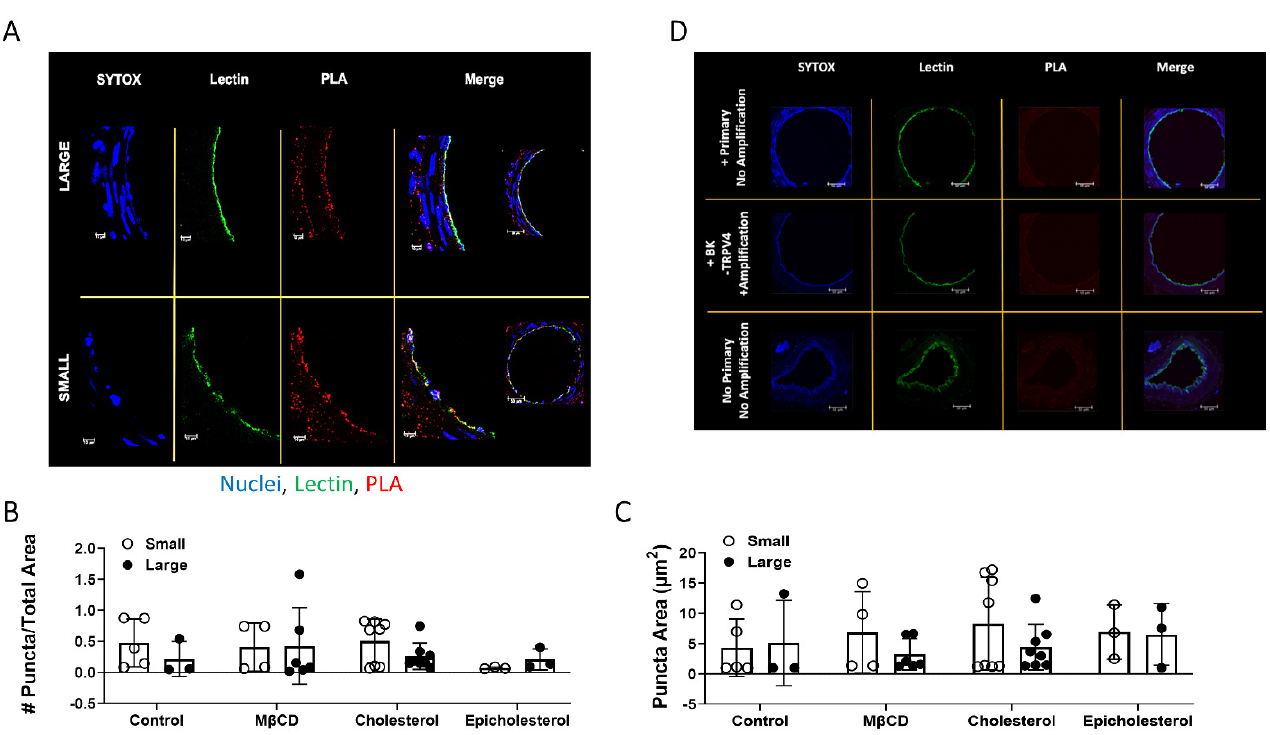
Figure 5. Endothelial TRPV4 and BK association in large and small mesenteric arteries following sterol manipulation. ( A ). Representative images of mesenteric artery cross-sections with endothelial glycoprotein marker Lectin (green) and PLA puncta for TRPV4/BK association (red). Nuclei are labeled with SYTOX (blue). ( B ). Number (#) of puncta count /total area and ( C ). area of puncta from 23 arteries/size group per animal. Mean ± S.D. n = 4 animals/group. ( D ). Primary antibodies without ligation or amplification (+Prim/No Amp); inclusion of BK but not TRPV4 primary antibody with ligation and amplification (+BK/-TRPV4/+Amp); and No primary No amplification as negative con- trols.